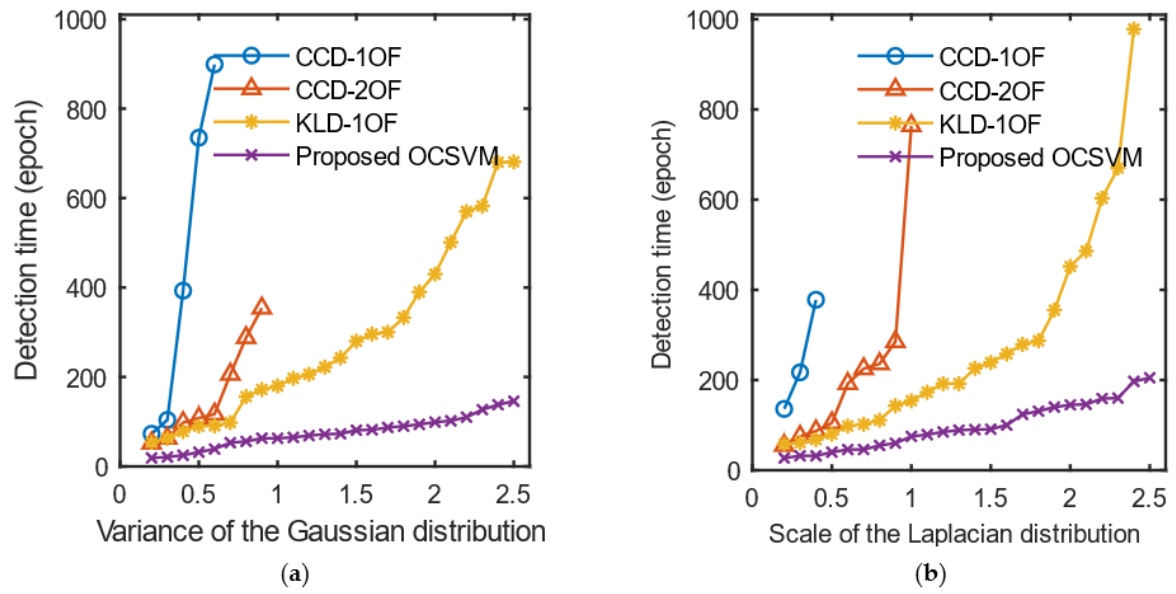
Figure 9. Variations of the ionospheric anomaly time in relation to Gaussian ( a ) and Laplacian ( b ) noise levels when the CCD-1OF, CCD-2OF, KLD-1OF and OCSVM-based monitors are applied. Ionospheric anomalies that cannot be detected are not shown in the figure.